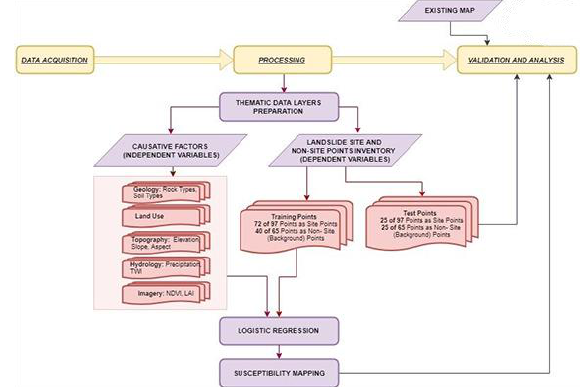
Figure 2. Flowchart of the methodolo